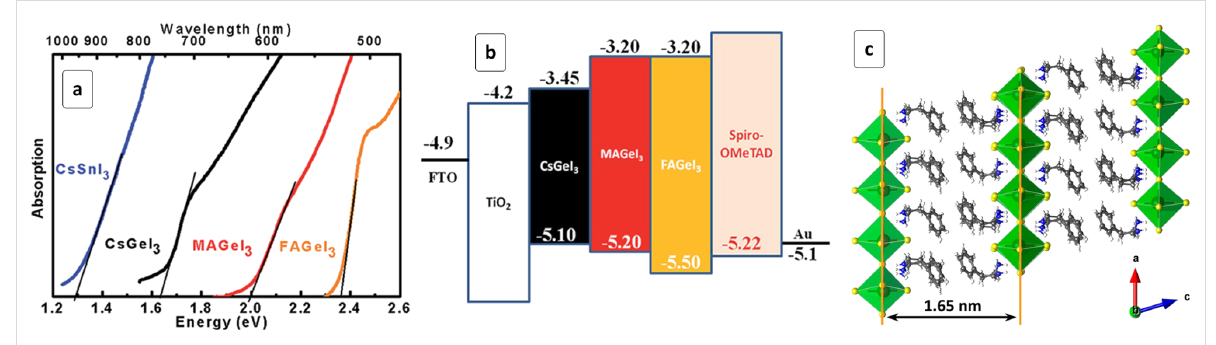
Figure 9: (a) Absorption spectra of AGeI 3 HPs with different cations; (b) energy level alignment in solar cells with AGeI 3 HPs; (c) structure of layered (PEA) 2 GeI 4 HP. (a,b) Reprinted with permission from [140], copyright 2015 The Royal Society of Chemistry; (c) Reprinted with permission from [143], copyright 2017 American Chemical